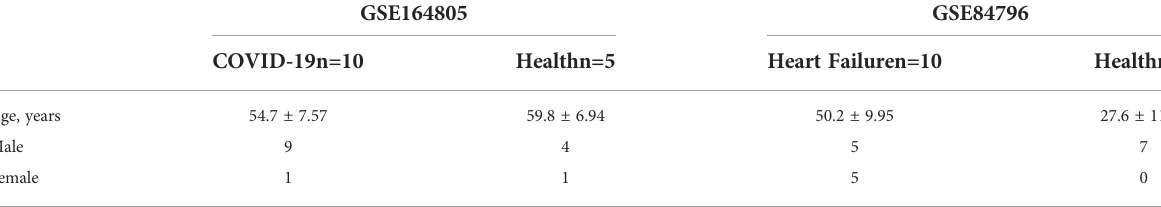
TABLE 1 Demographic characteristics of study